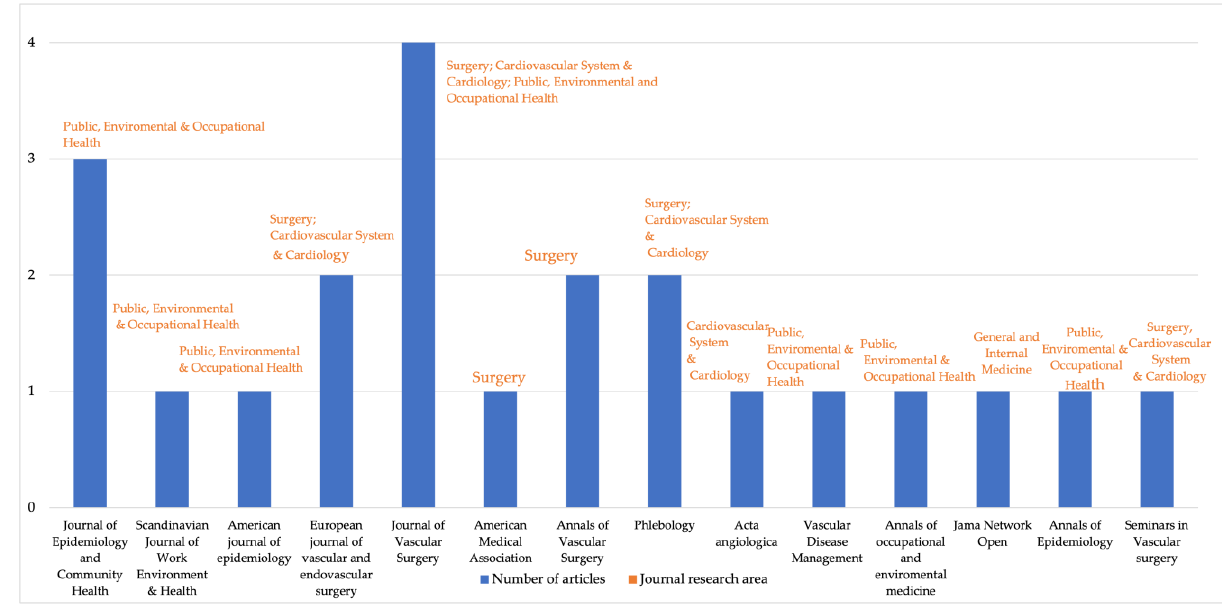
Figure 3. Journal list.